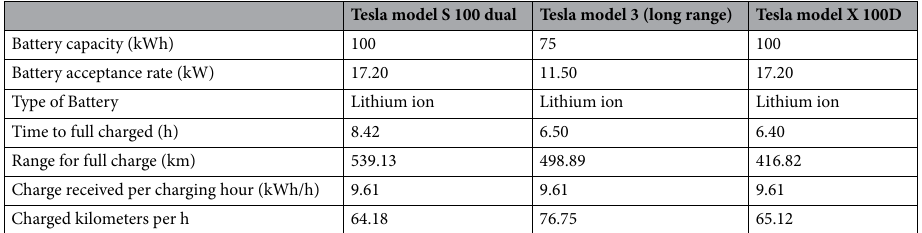
Table 3. Charging information for